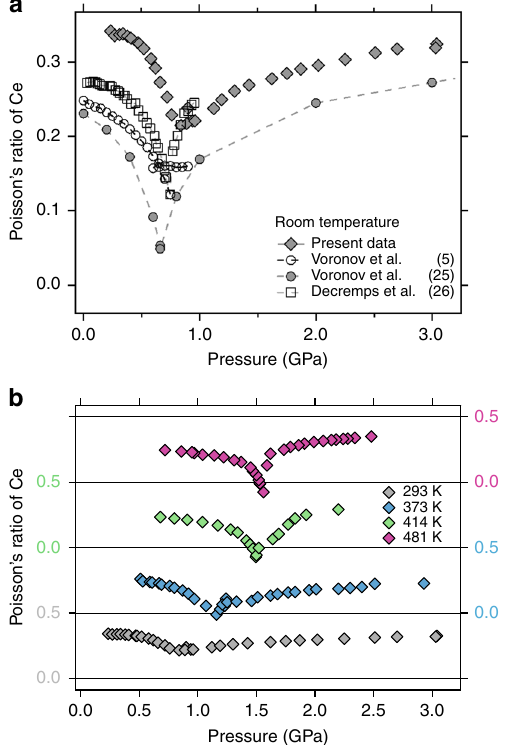
Fig. 4 The Poisson ’ s ratio ν = (3 B − 2 G )/(6 B + 2 G ) versus pressure. a Comparison of ambient temperature values. Values from refs. 25, 26 are calculated from their published results for B and G . b The Poisson ’ s ratio versus pressure for different temperatures. The horizontal lines represent values of 0 and 0.5. Towards T C the width of the transition decreases and the minimum becomes deeper and negative. Uncertainty in pressure is < 0.05 GPa and the symbols for the present data are larger than the error